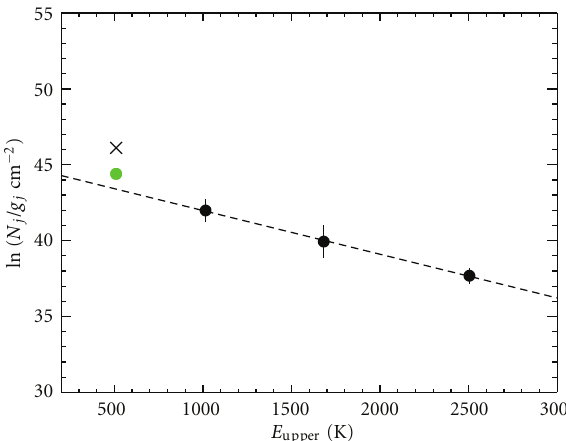
Figure 6: H 2 rotation diagram: for each transition the column den- sity N j normalized to the statistical weight of the state ( g j ) is plotted as a function of the upper level energy [34]. The dashed line repre- sents the best LTE fit obtained for S(1), S(2), and S(3) transitions (black points). For completeness we plot also the S(0) observation (black cross) and the measurement corrected for aperture e ff ects (green